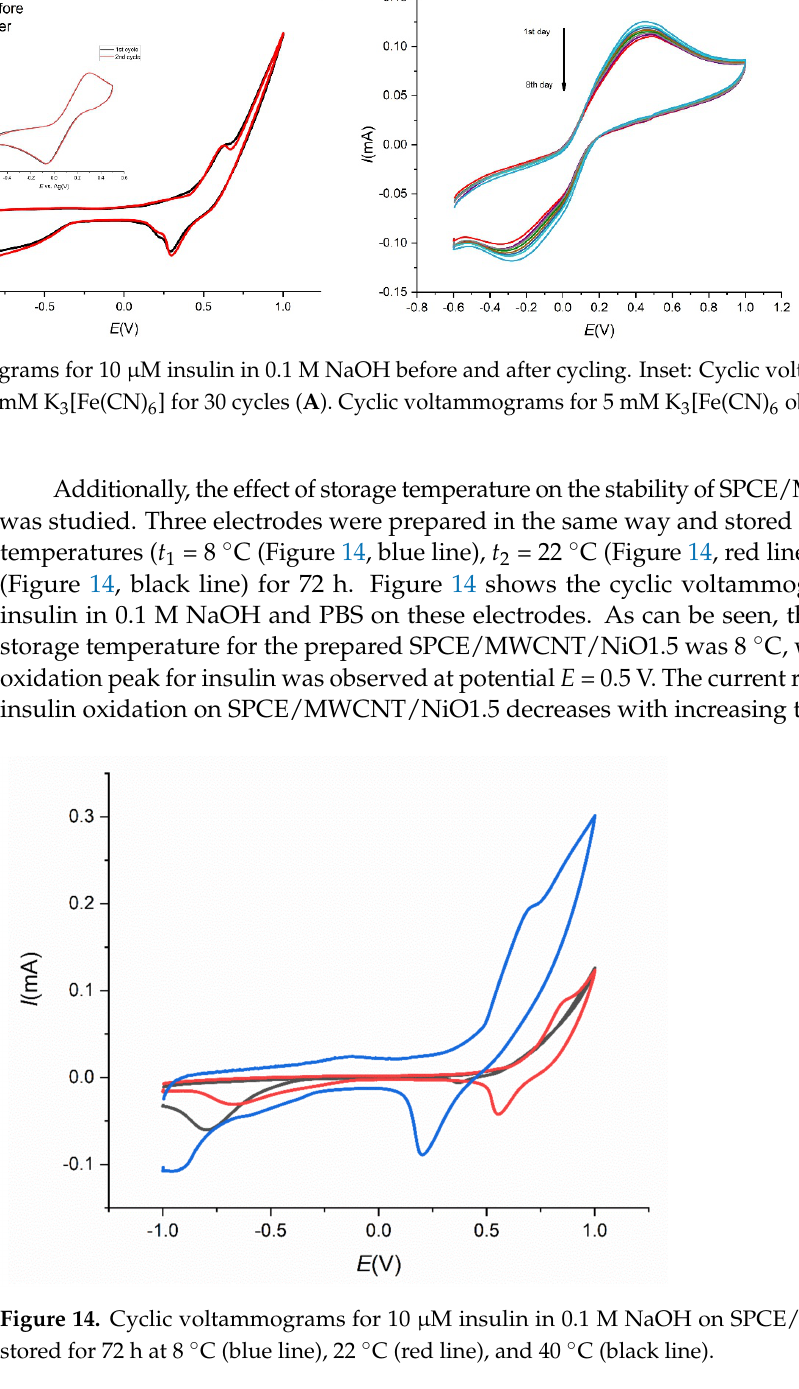
Figure 12. Cyclic voltammograms for the pure blood serum and blood serum samples with 2 µM and 5 µM insulin.